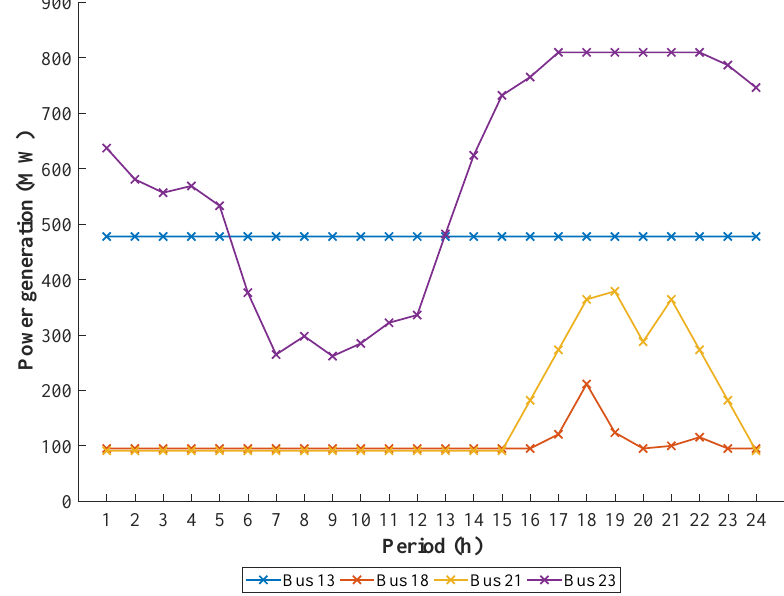
Figure 9. Hydro and thermal power generation values in Case 1.